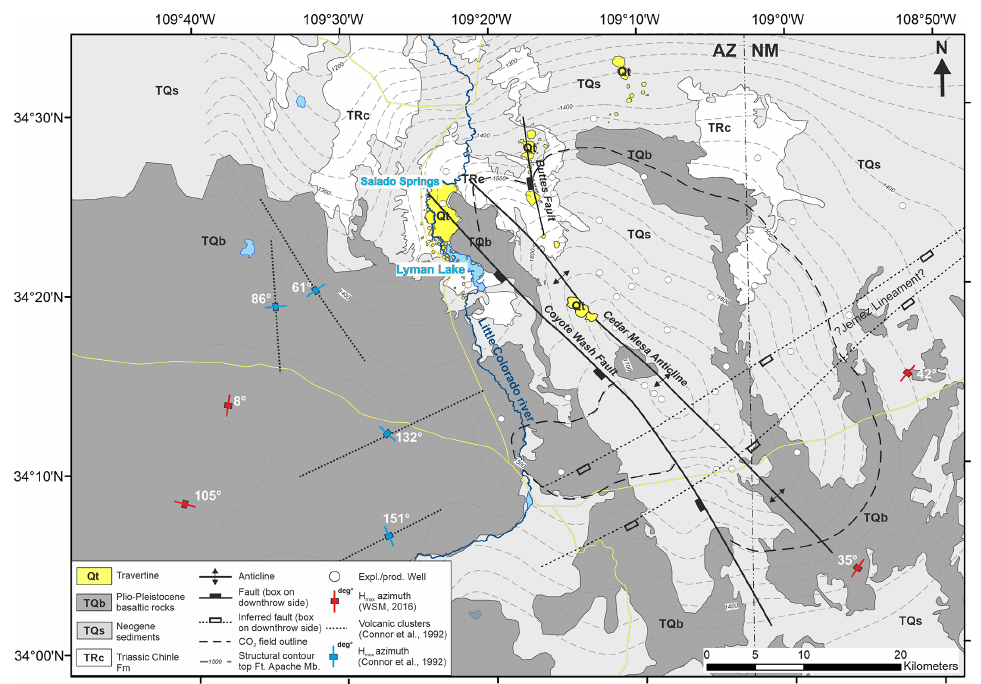
Figure 2. Geological map of the St. Johns Dome natural CO 2 reservoir showing the present-day extent of the CO 2 reservoir, the location of the travertine deposits, orientation of the studied faults and the location of exploration and production wells used to build the subsurface model. Structural contours indicate the top of the Fort Apache Member and illustrate the faulted anticline setting. Stress field markers indicate the azimuth of maximum horizontal stress (SH max ) after the World Stress Map in red and from volcanic clusters in blue.